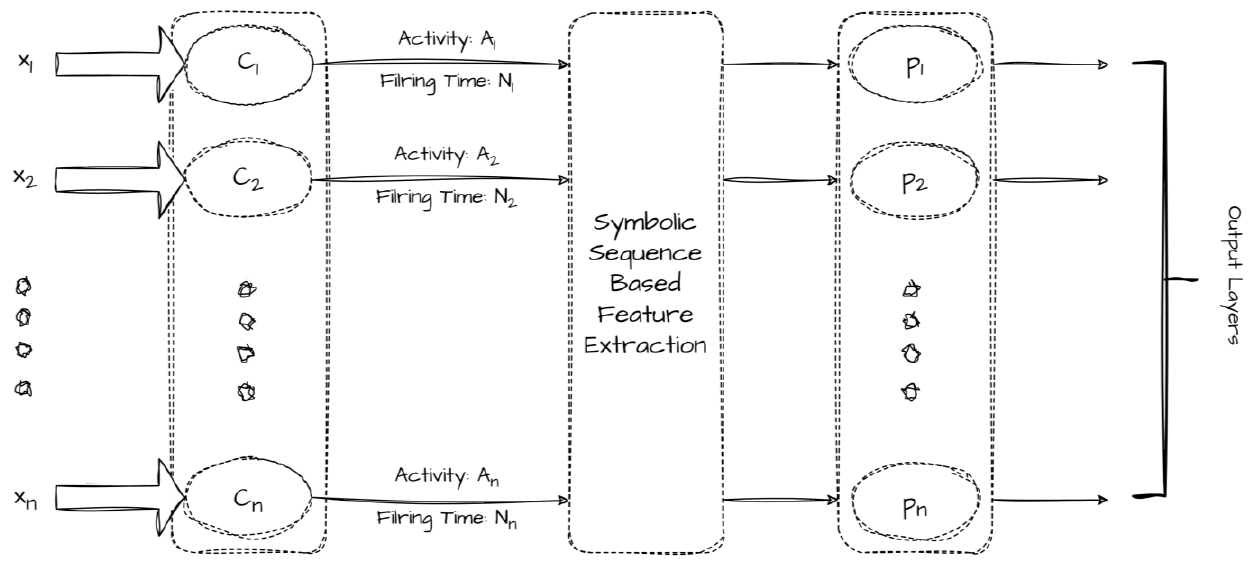
Figure 2. The architecture of ChaosNet (Balakrishnan et al. 2019) Luröth neural networks for purposes relating to classification. 𝐶 1 , 𝐶 2 , …, 𝐶 𝑛 are the unit dimensional GLS neurons. Each neuron initially exhibits 𝑞 units of normalized neuronal activity. The input to the network, or the normalized collection of stimuli, is denoted by the {𝑥 𝑖 } 𝑖=1𝑛 . When a GLS neuron 𝐶 𝑖 ’s chaotic activity value 𝐴 𝑖 ( 𝑡 ), starting from initial neural activity ( 𝑞 ), reaches the 𝜀 -a neighborhood of stimulus, it stops firing chaotically. This neuron has a “firing time” of 𝑁 𝑖 ms. 𝐴𝑖 ( 𝑡 ) contains topological transitivity symbolic sequence feature 𝑝𝑖 . This feature is extracted from the 𝐴𝑖 ( 𝑡 ) of the 𝐶 𝑖 ’s GLS-neuron.